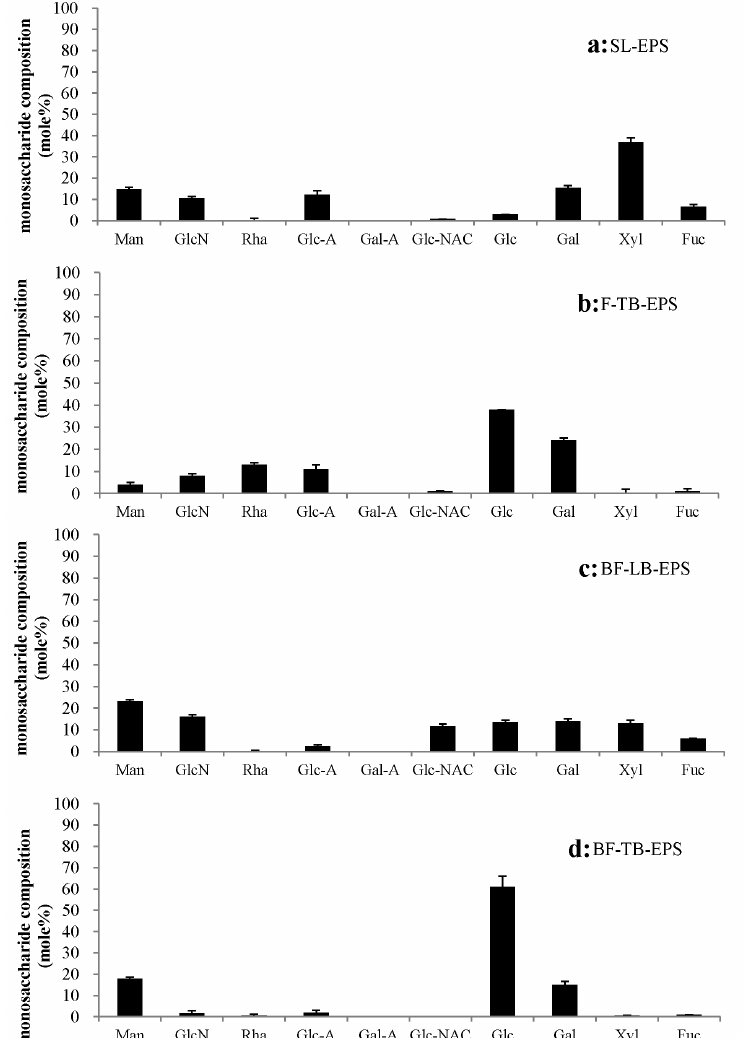
Figure 3 - The monosaccharides compositions in terms of mole percentages for EPS fractions from Stauroneis sp. The mole percentages were calculated based on the HPLC peak areas of at least 3 replicated samples, and the means and standard deviations are shown as closed columns and bars, respectively. The unknown monosaccharides were ignored in the mole percentage calculations. a , b , c , and d represent the samples of SL-EPS, F-TB-EPS, BF-LB-EPS and BF-TB-EPS,